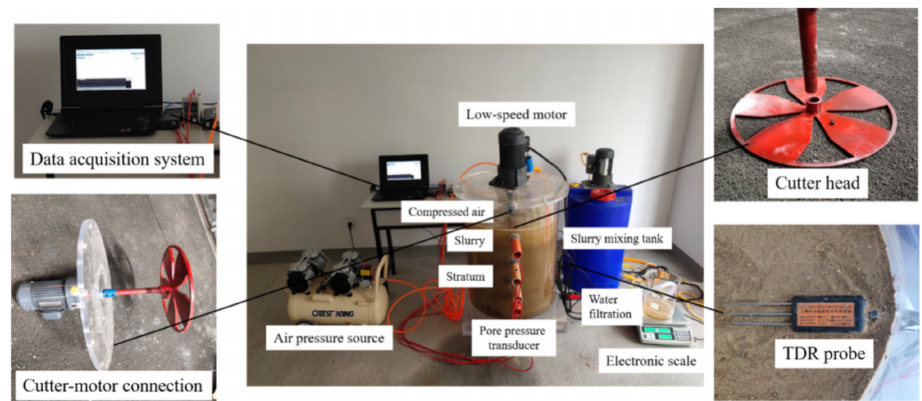
Figure 6. Slurry permeation test system for slurry shield tunneling.